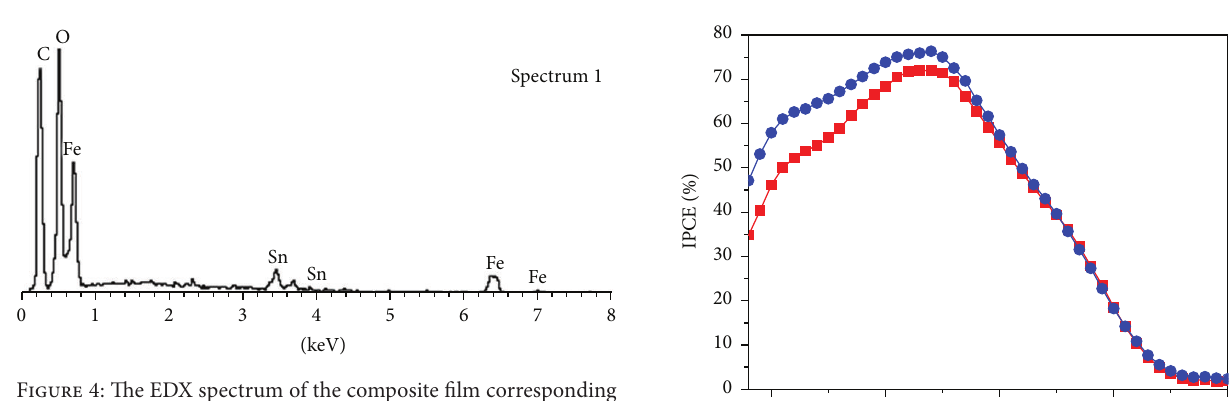
Figure 4: The EDX spectrum of the composite film corresponding to the Figure 1.